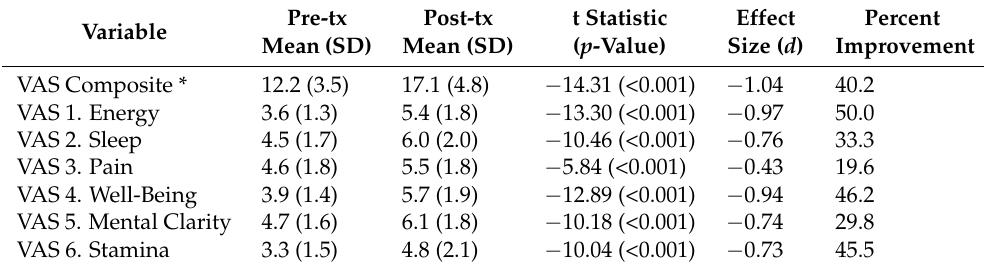
Table 2. Change in VAS Scores with Treatment in Full Sample ( n = 188).